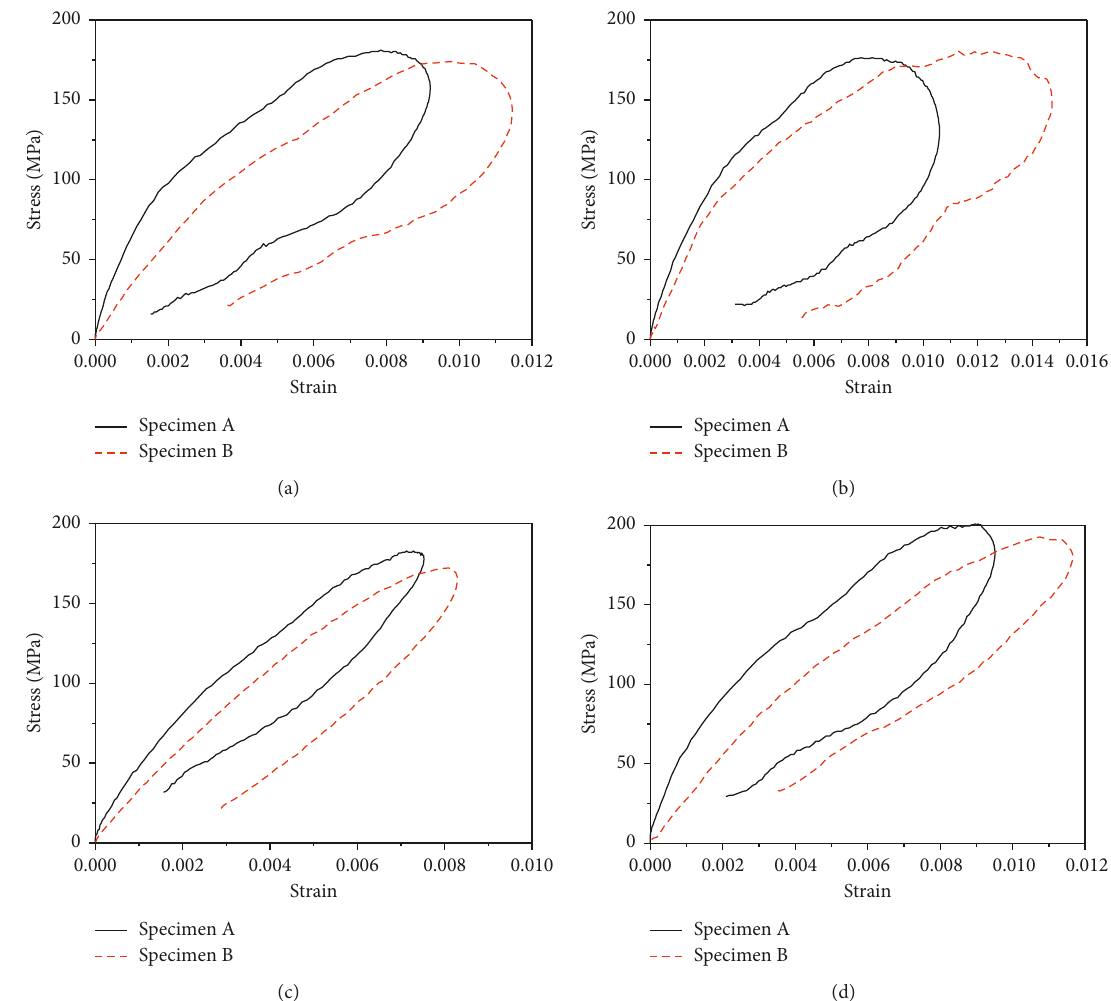
Figure 5: Stress and strain curves for the sandstone under dynamic loading with (a) impact at 0.6MPa pressure under a confining pressure of 5MPa, (b) impact at 0.7 MPa pressure under a confining pressure of 5MPa, (c) impact at 0.6MPa pressure under a confining pressure of 10MPa, and (d) impact at 0.7 MPa pressure under a confining pressure of 10